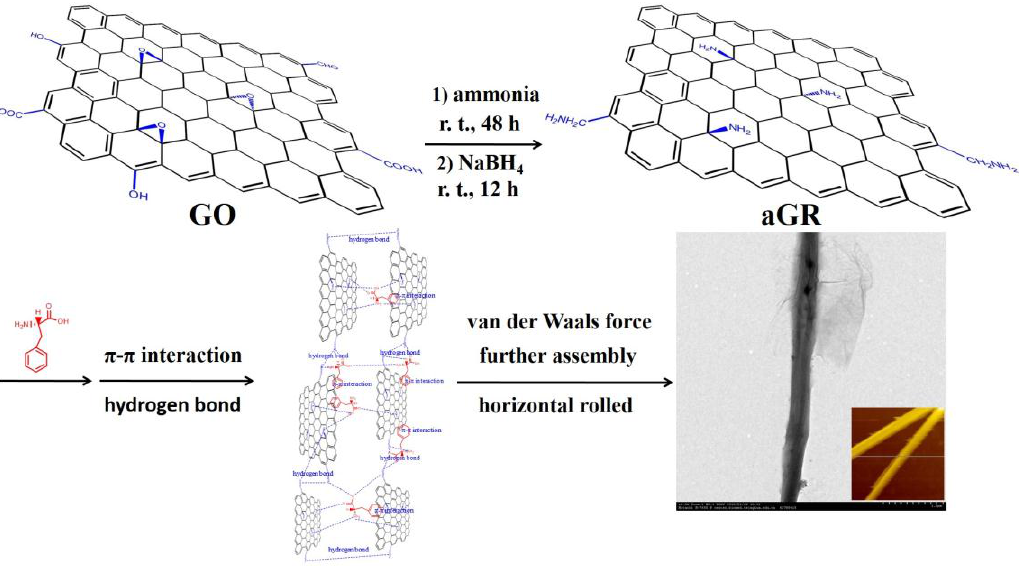
Figure 6. Possible mechanism for the aLGN formation.